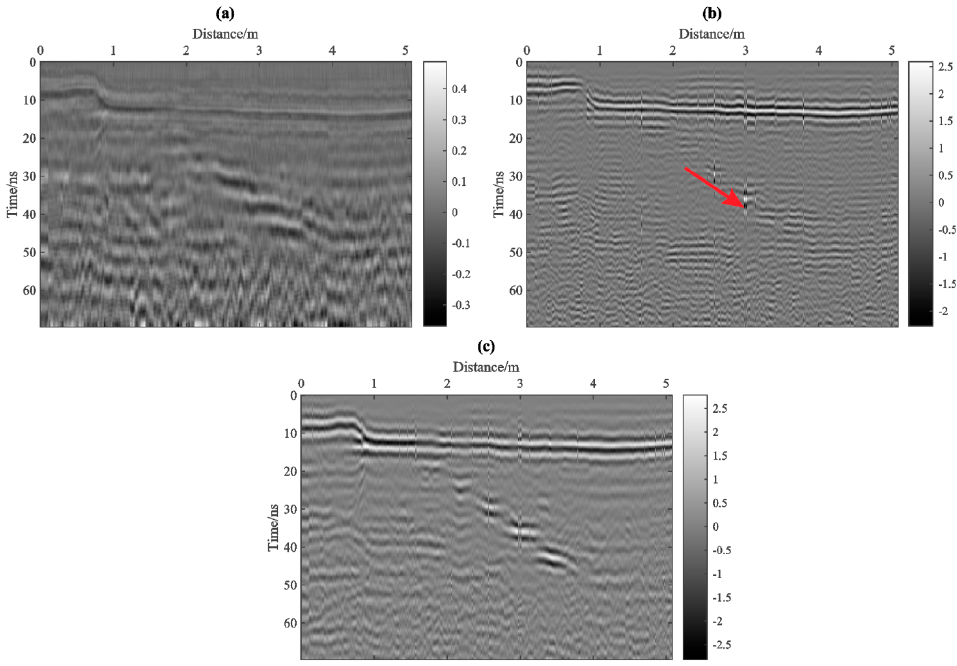
Figure 16. The MVMD-based TKEO-slices of the field data. ( a − c ) show the TKEO-slices 1 − 3, respectively.